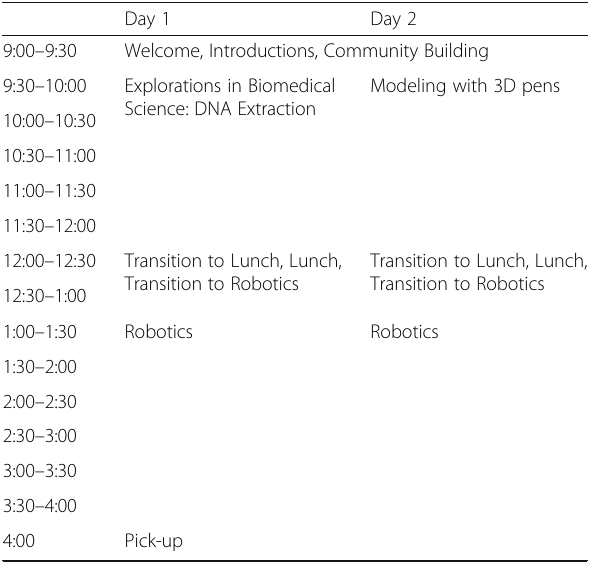
Table 1 Sample daily schedule used in See Blue See STEM